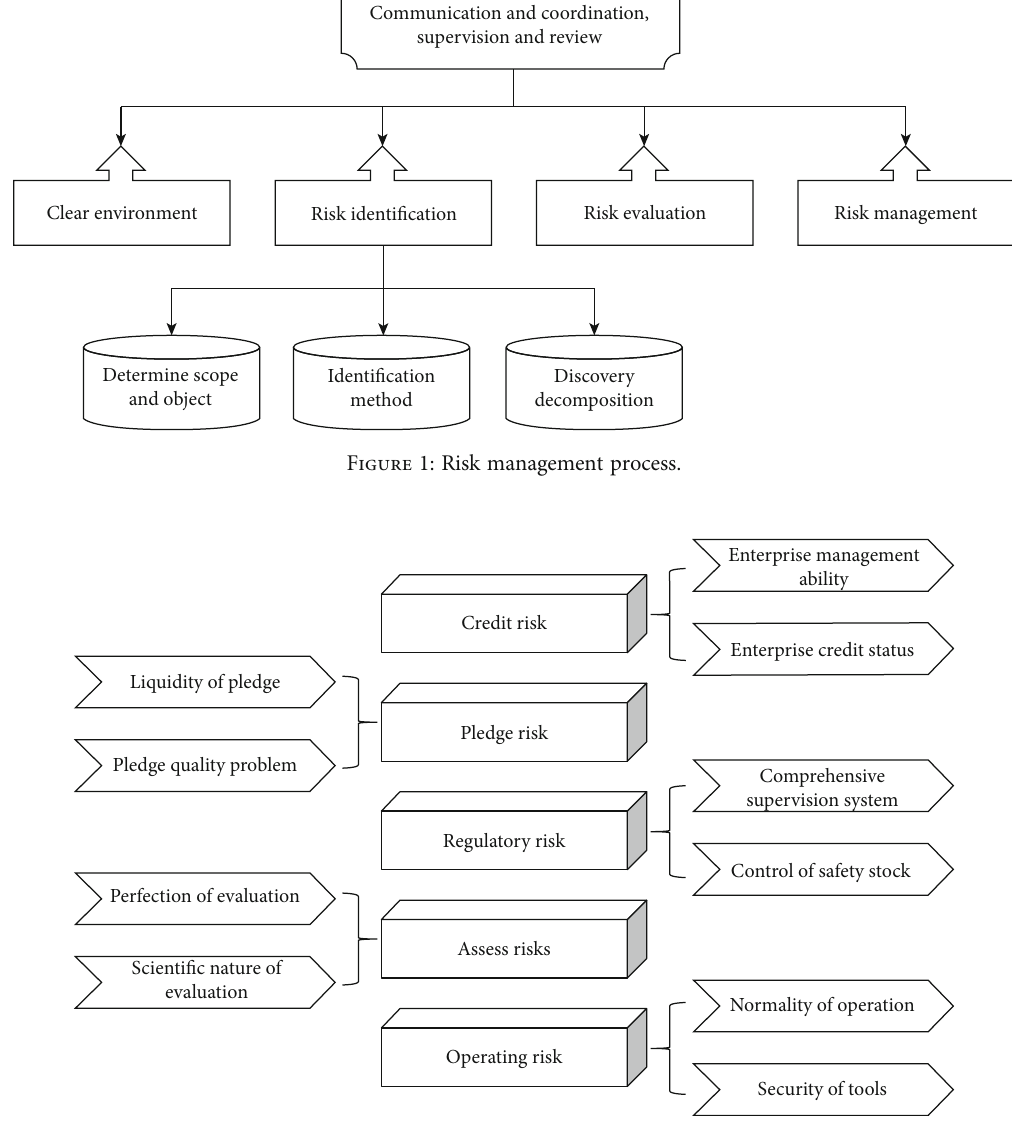
Figure 2: Initial evaluation index system of logistics